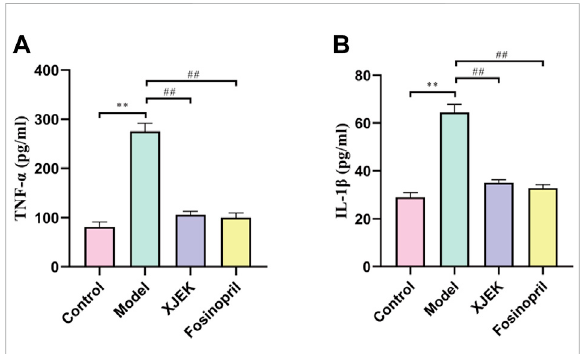
FIGURE 4 Serum levels of in fl ammatory cytokines. Serum TNF- α (A) and IL-1 β (B) levels at 6 weeks post-MIR were presented here. pp p < 0.01 versus control group, ## p < 0.01 versus MIR model group. Data were expressed as mean ± SD ( n = 6 mice for each